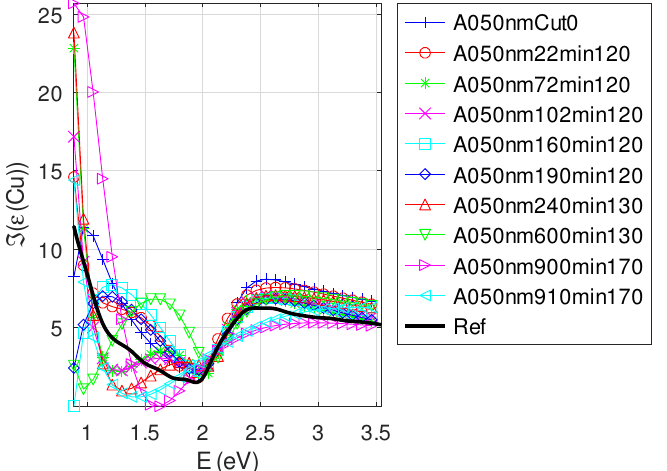
Figure A13. Imaginary part of the relative permittivity of copper as a function of the photon energy: bulk (black) and best calculated (color) for each oxidized sample (initial thickness h 0